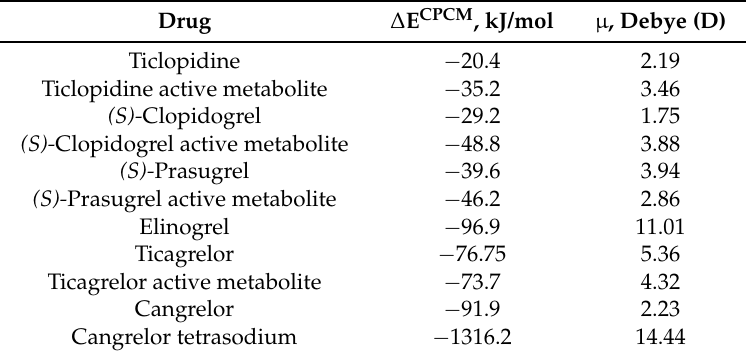
Table 2. The solvation energies (water) and dipole moments of the drugs studied. Drug ∆ E CPCM , kJ/mol µ , Debye (D) Ticlopidine ´